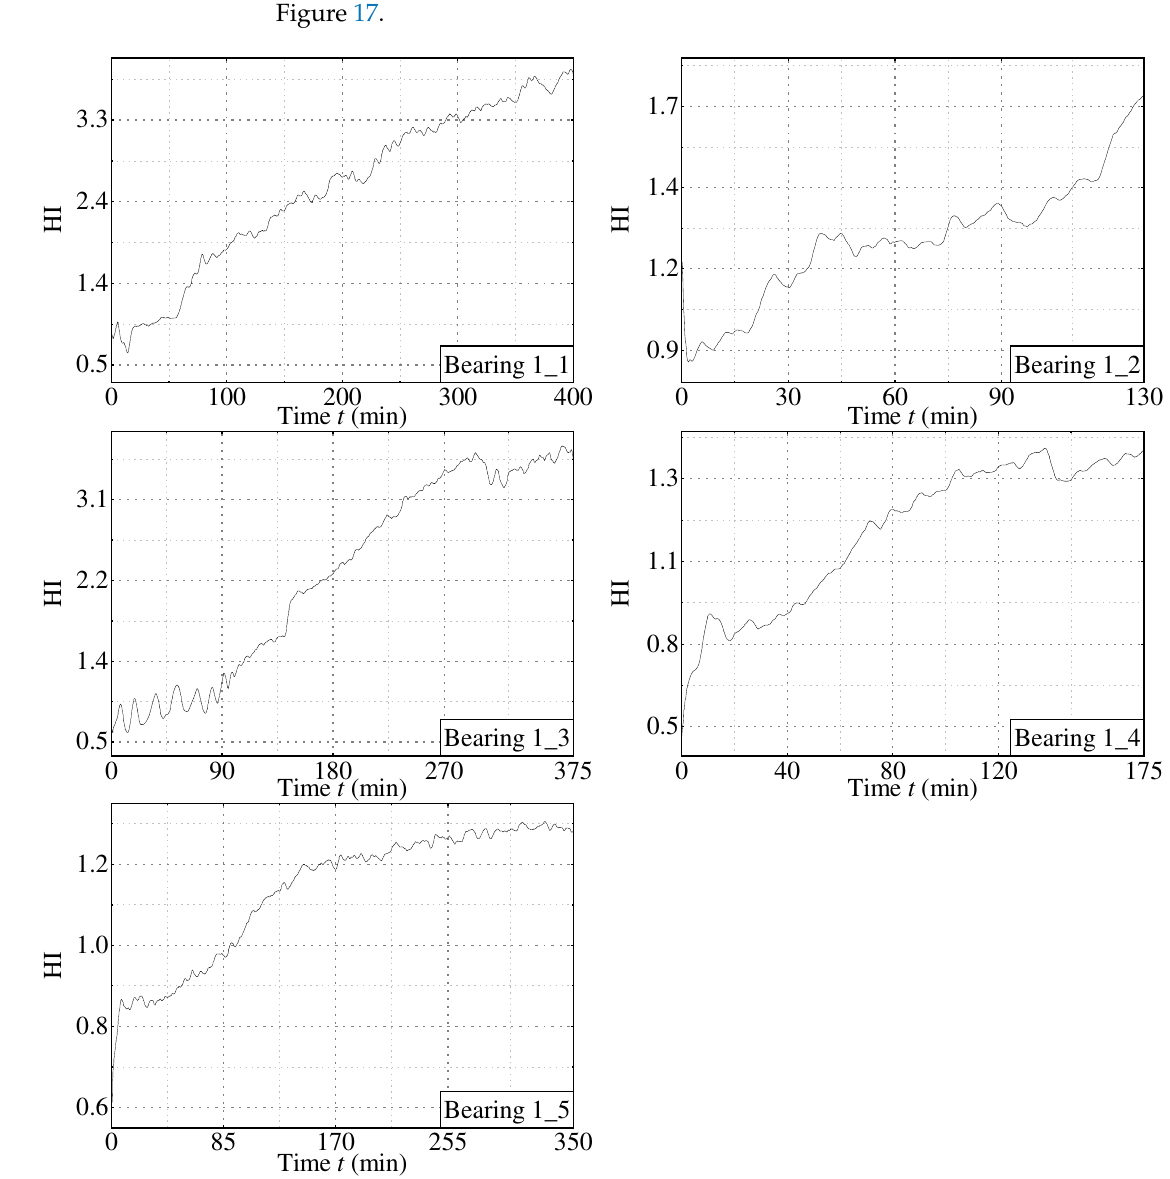
Figure 17. HI curves of the training bearings.